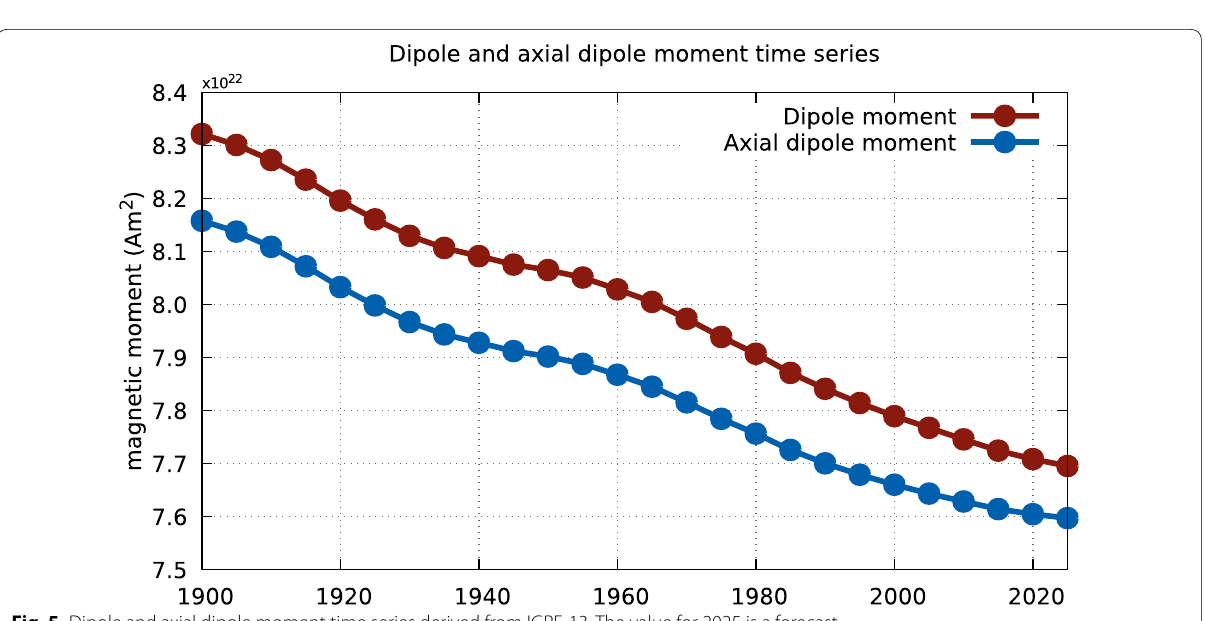
Fig. 5 Dipole and axial dipole moment time series derived from IGRF‑13. The value for 2025 is a